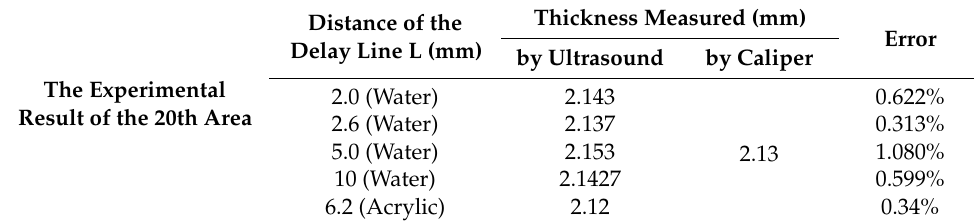
Table 3. Coating thickness measurements by caliper and ultrasound at 20th area.